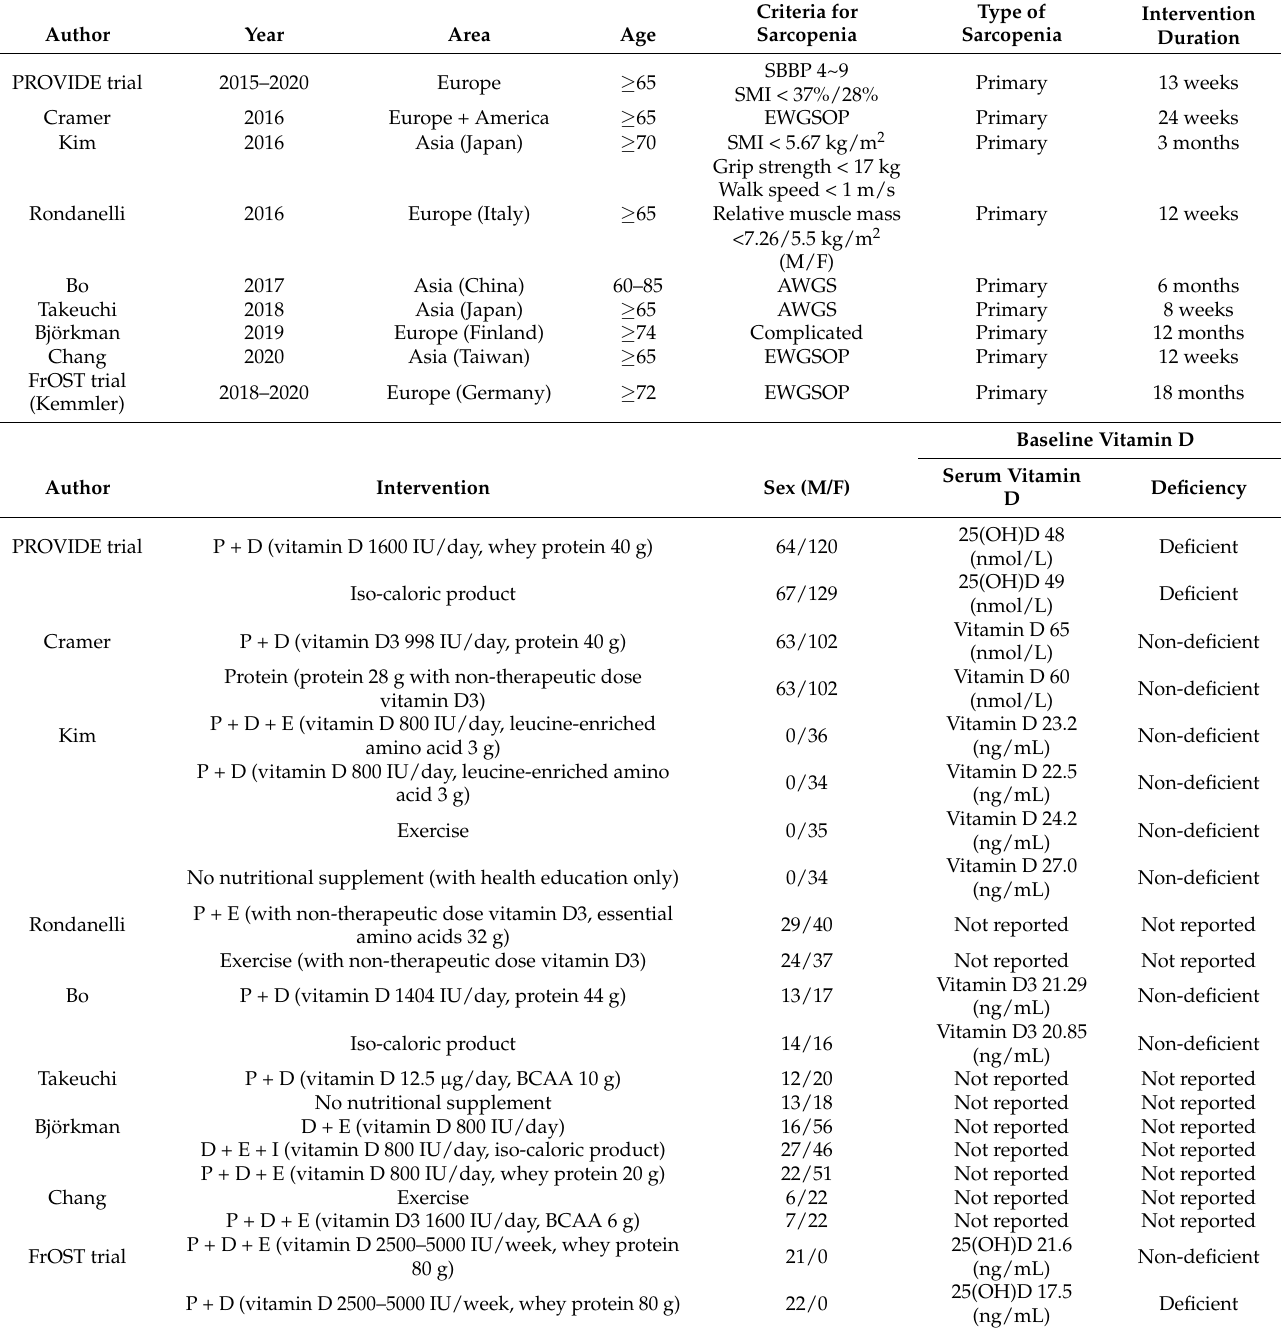
Table 1. Characteristics of the included randomized controlled